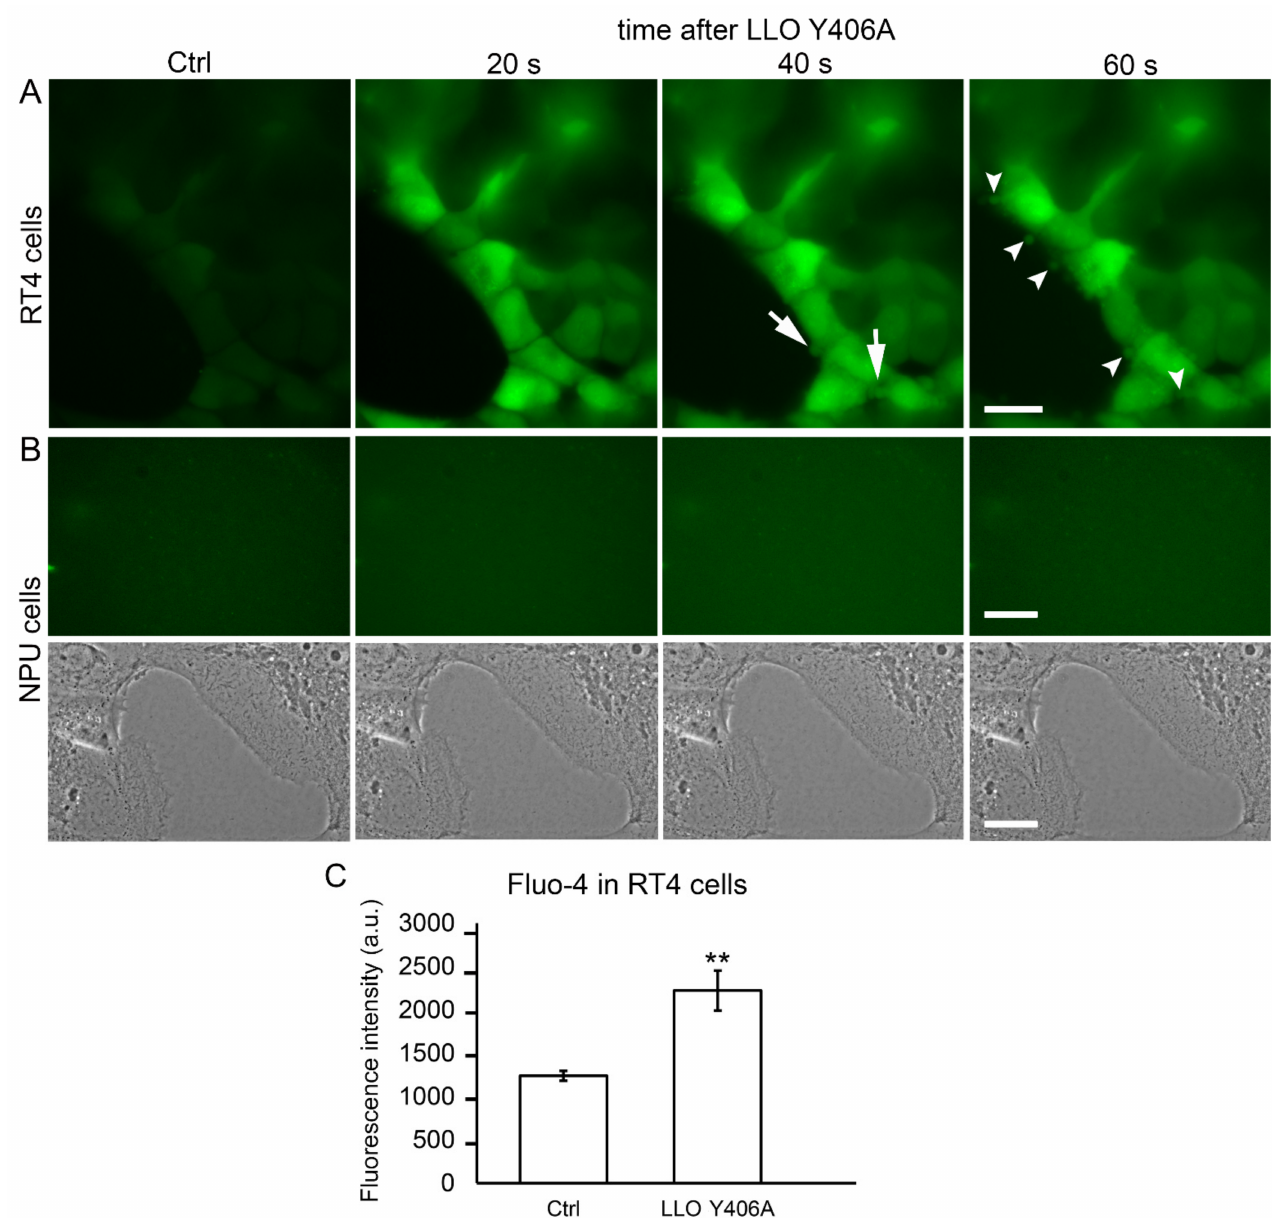
Figure 5. LLO Y406A induces an influx of calcium into RT4 cells. ( A ) Fluorescence of the calcium indicator Fluo-4 in RT4 cells without LLO Y406A and 20, 40, and 60 s after 0.5 µ M LLO Y406A incubation. Cell blebbing occurs 40 s after LLO Y406A incubation (arrows), followed by the release of extracellular vesicles 60 s after LLO Y406A incubation (arrowheads). ( B ) Fluorescence of Fluo-4 in NPU cells without LLO Y406A and 20, 40, and 60 s after 0.5 µ M LLO Y406A incubation. LLO Y406A did not induce calcium influx in NPU cells. No fluorescence of Fluo-4 (upper row) and no changes in morphology (bottom row) appeared during 60 s after 0.5 µ M LLO Y406A incubation. Images of RT4 and NPU cells were acquired with the same exposure time (558.47 ms). Scale bars are 20 µ m. ( C ) Quantification of Fluo-4 fluorescence, presented as gray values of the fluorescence intensity signal (a.u.), in RT4 cells in the absence of LLO Y406A and 60 s after treatment with LLO Y406A. Presented are averages ± SEM, ** p <